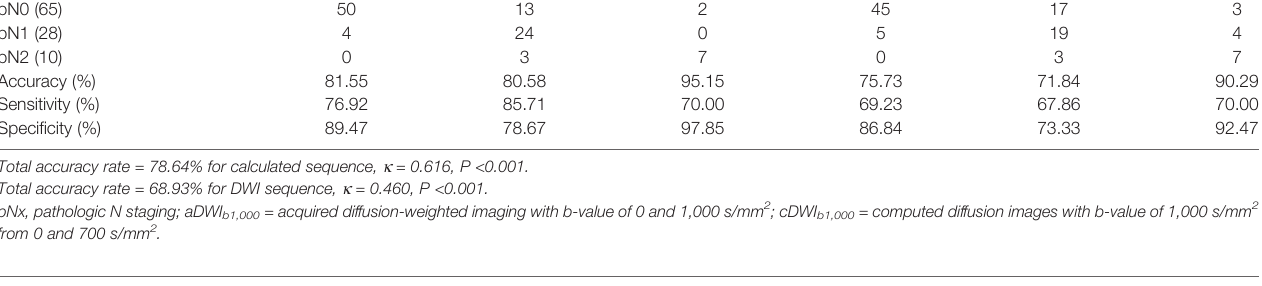
TABLE 4 | Comparisons of Image Quality Between cDWI b1,000 and aDWI b1,000 images. Parameters cDWI b1,000 Sharpness*